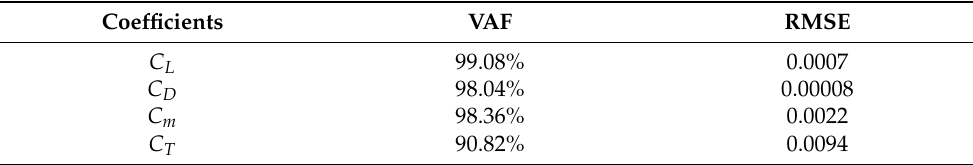
Table 1. The matching function of the polynomial